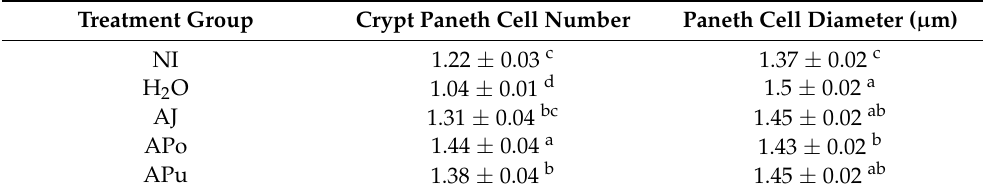
Table 6. Effect of the intra-amniotic administration of apple fraction soluble extracts on Paneth cells. Treatment